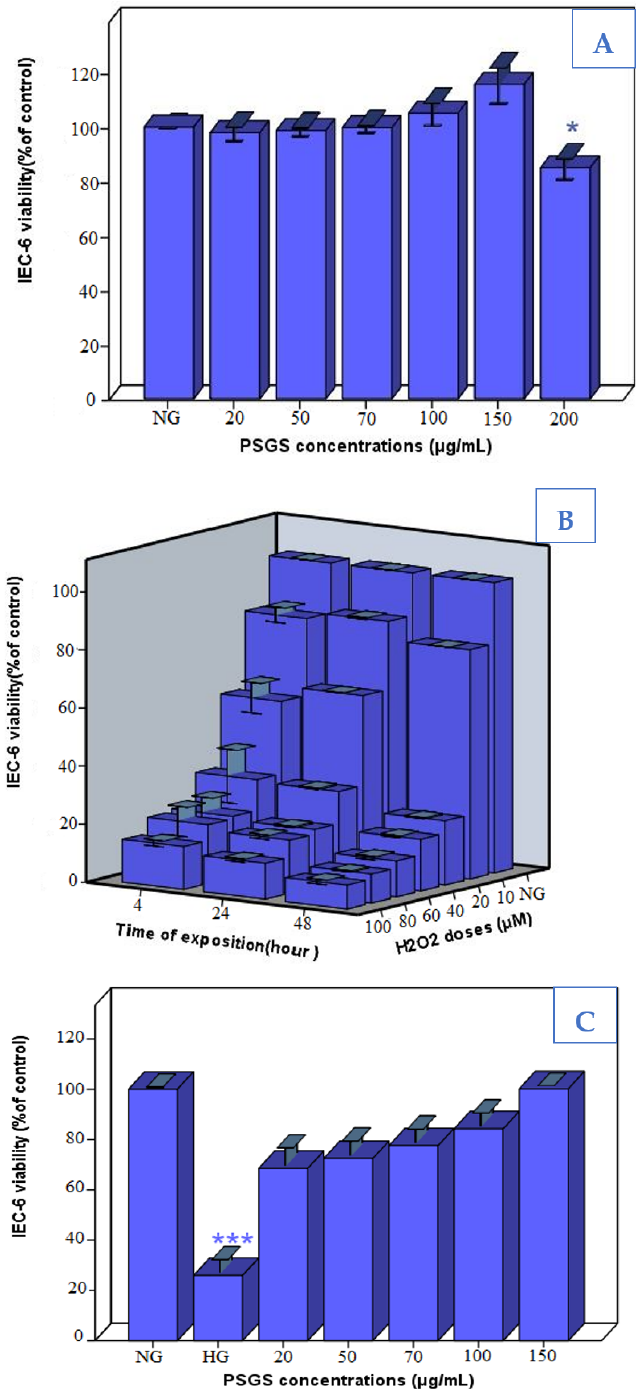
Figure 5. ( A ) Toxicity test of PSGS on cell viability of IEC-6 cells (% of control), ( B ) Effects of H 2 O 2 on cell viability of IEC-6 cells (% of control), ( C ) Effects of PSGS on cell viability in H 2 O 2 -injured IEC ‐ 6 cells (% of control).NG (Normal group) HG (treated group with H 2 O 2 ) Error bars represent standard deviations of three replications. Bars marked with (*) are significantly different from the normal group at * p < 0.05; *** p < 0.001.